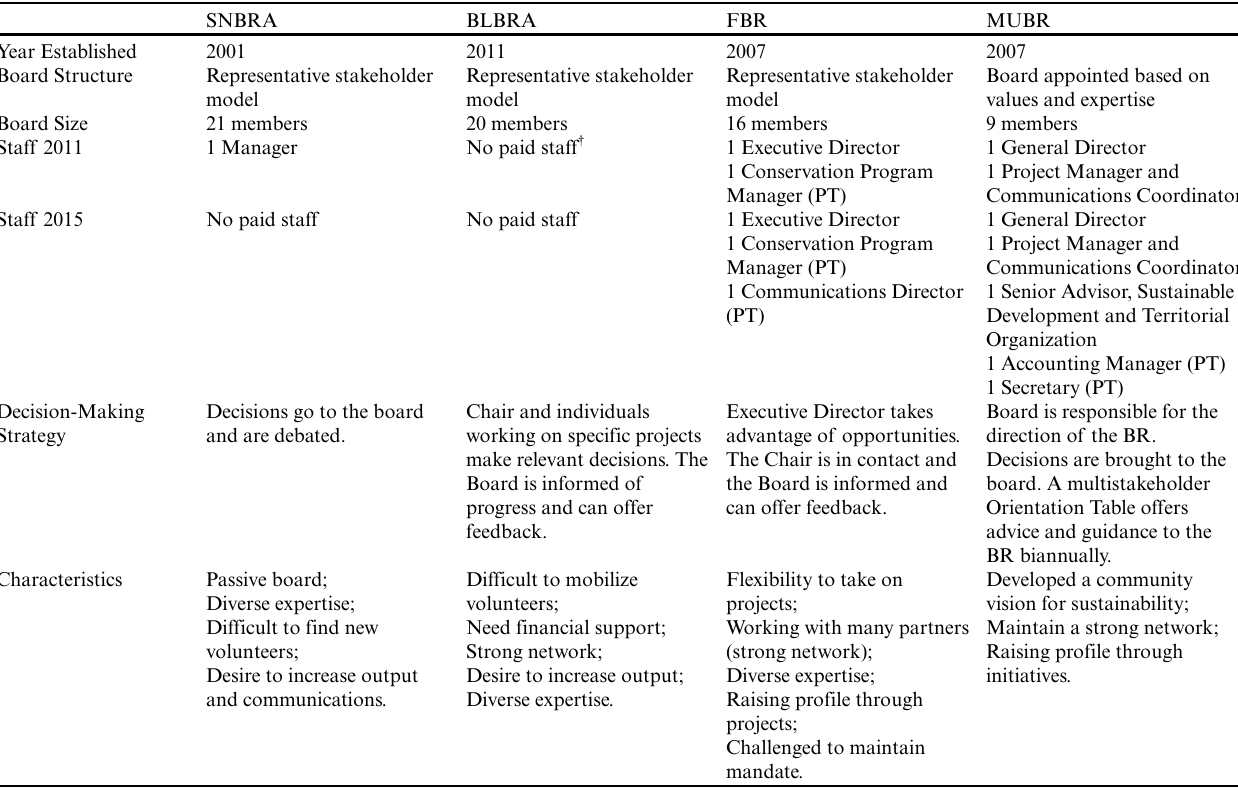
Table 1 . Summary table of characteristics of the biosphere reserves (BRs) explored, including Southwest Nova Biosphere Reserve (SNBRA), Bras D’Or Lake Biosphere Reserve (BLBRA), Fundy Biosphere Reserve (FBR), and Manicouagan-Uapishka Biosphere Reserve (MUBR). † BLBRA was established after Environment Canada money was allocated to the BRs and, therefore, never had federal funding. BRs also receive funding for summer students and short project contracts not included